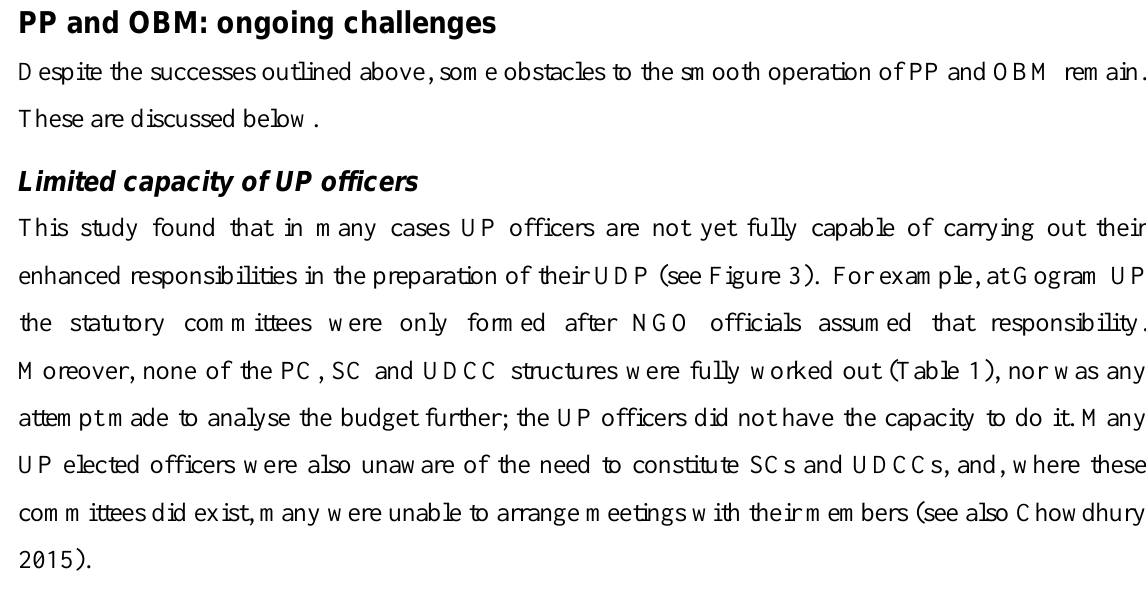
Figure 3: Participatory budgeting process: contrast between statutory requirements and practice Official UP planning and budgeting process Actual UP planning and budgeting